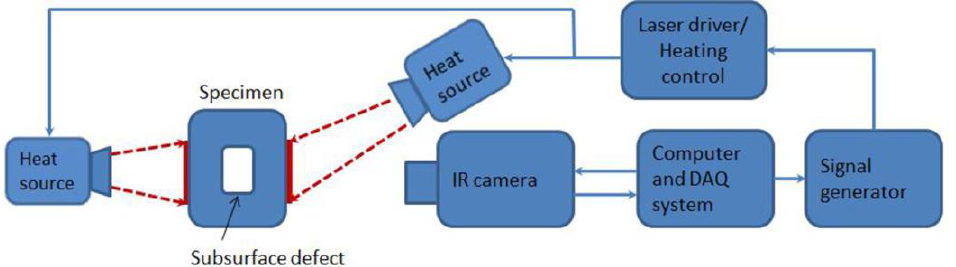
Figure 15. Schematic of active thermography system. Adapted with permission from Ref. [161] 2022, AIP Publishing.